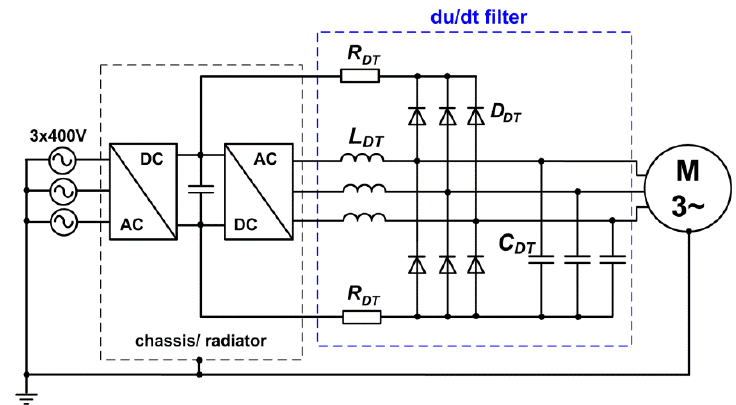
Figure 11. Electric drive with an exemplary du/dt filter presented in